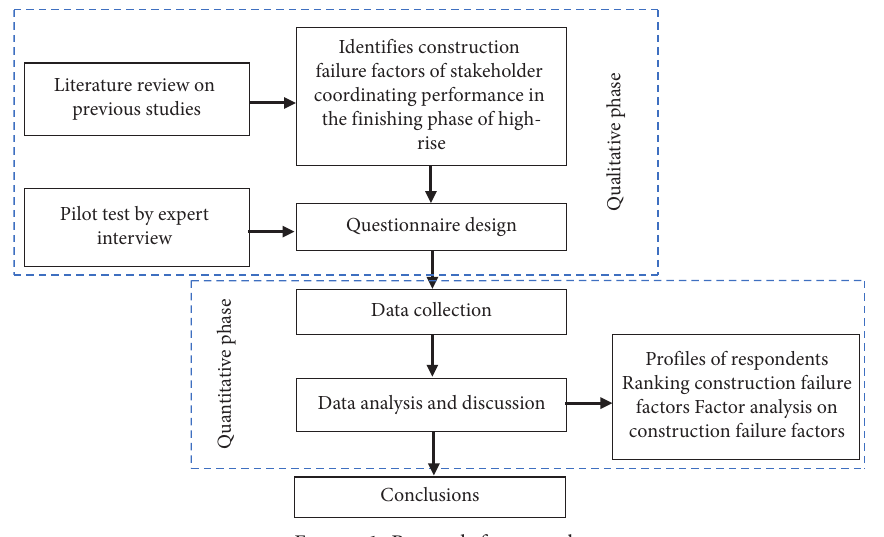
Figure 1: Research